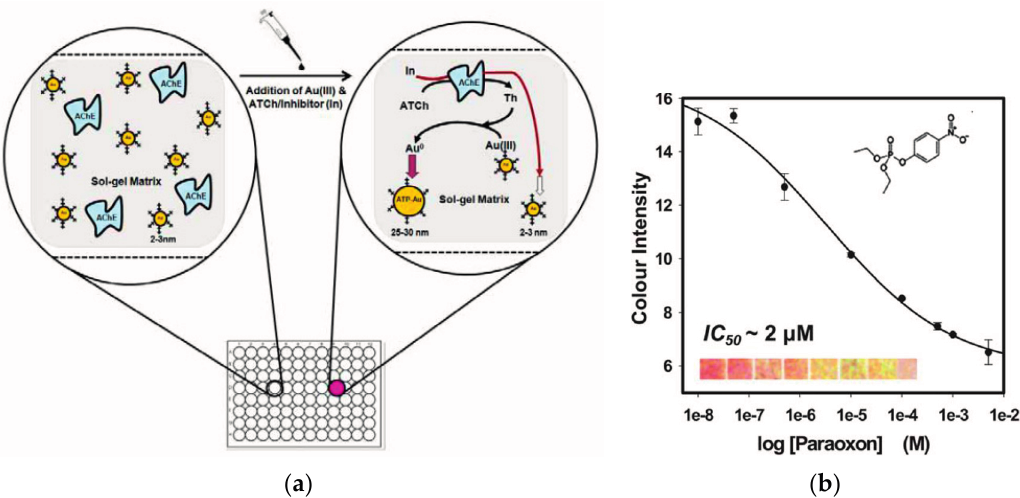
Figure 8. ( a ) Principle of a AChE colorimetric dipstick based on catalytic enlargement of AuNPs and ( b ) calibration curve for the detection of paraoxon (reproduced from [125] with permission of The Royal Society of